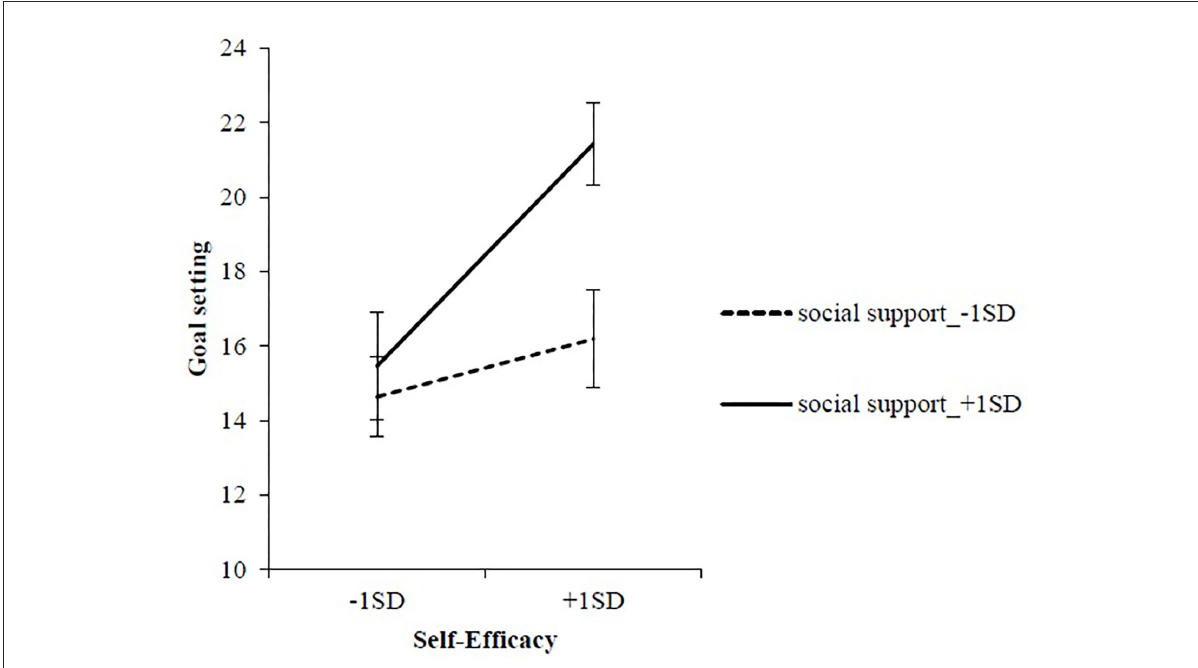
FIGURE1 The interaction between self-efficacy and social support related to goal setting in the pre-action